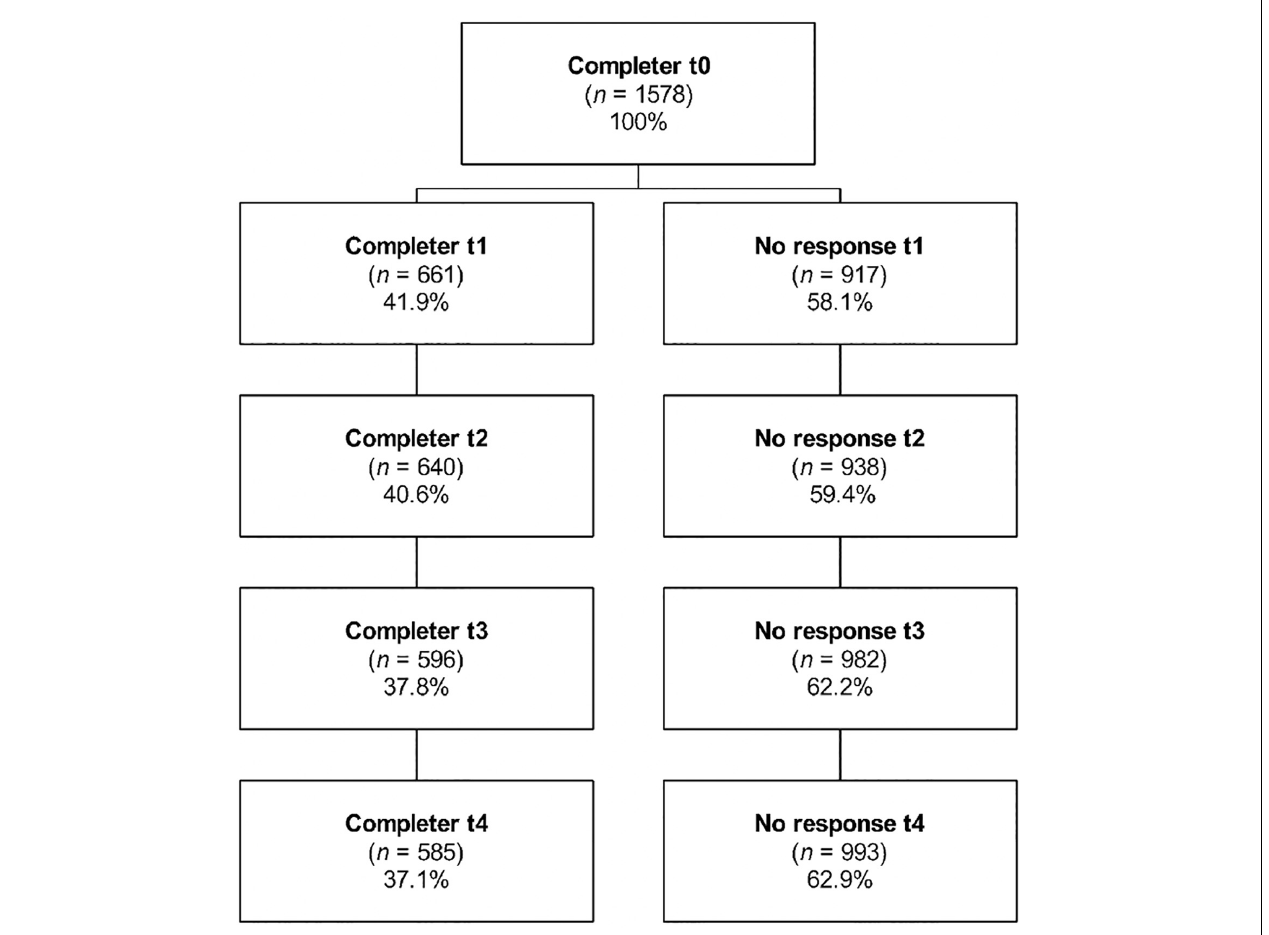
FIGURE 1 | Study flowchart. April 2020 (baseline -T0), July 2020 (T1), October 2020 (T2), January 2021 (T3), and April 2021 (T4). All T0 participants were contacted in the remaining four rounds and we accepted for analysis participants who responded at least in four of the five time-points. We did not exclude participants that had not replied to the survey in previous